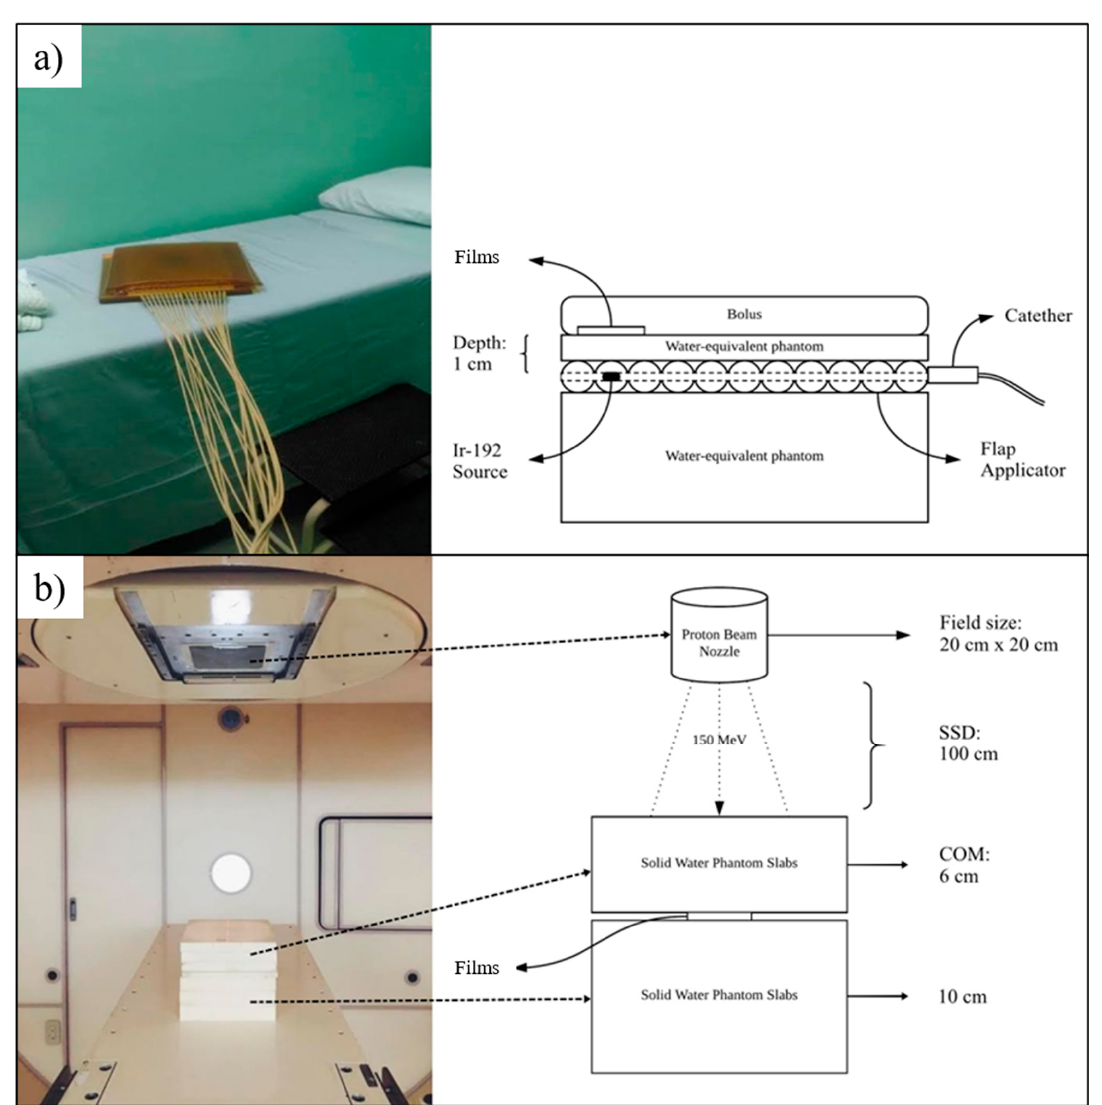
Figure 2. The irradiation setup and schematic diagram for ( a ) HDR Brachytherapy and, ( b ) proton beam therapy.